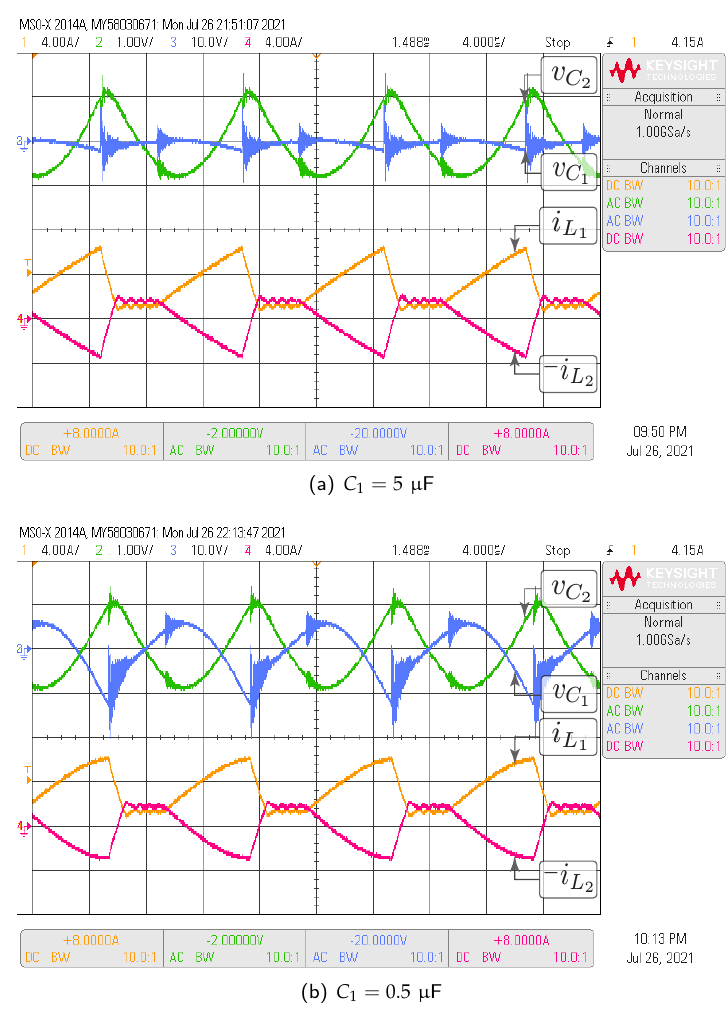
Figure 17. Experimental results for the Zeta converter with negative magnetic coupling which validate HIL results showed in Figure 12: ( a ) C 1 = 5 µ F, ( b ) C 1 = 0.5 µ F. CH1: i l (1 V/div, ac coupling), CH3: v C